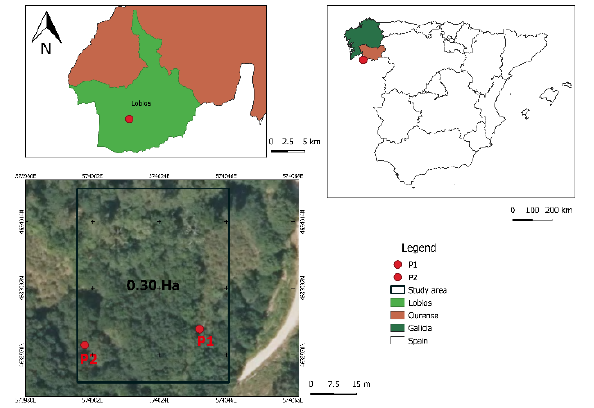
Figure 1 . Location of study